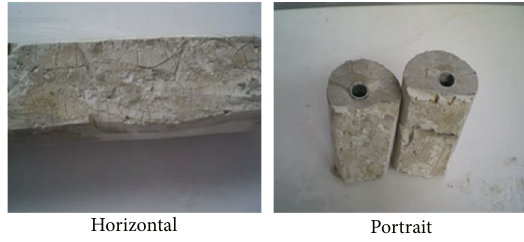
Figure 9: Schematic diagram when the gas and water are not completely